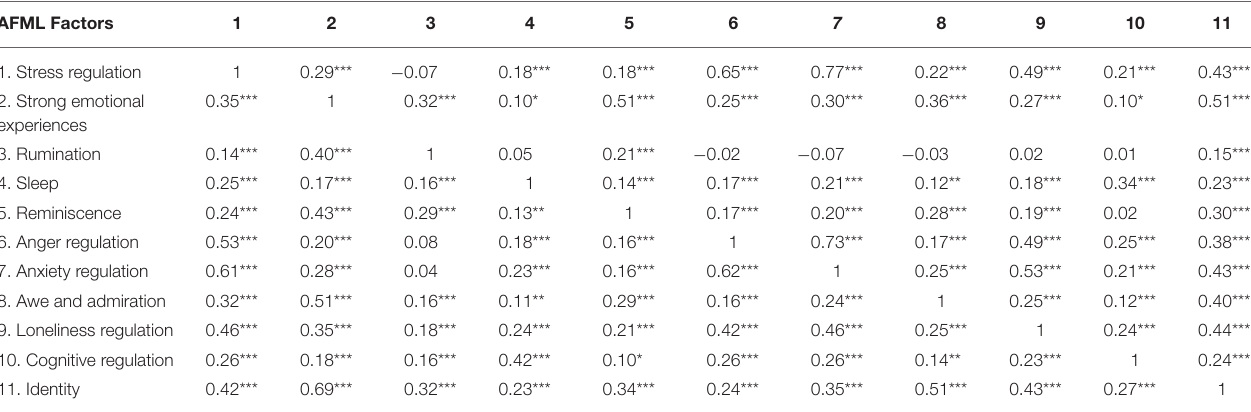
TABLE 5 | Bivariate correlations between factors of the AFML scale in the development sample (below the main diagonal), and bivariate correlations between factors of the AFML scale in the confirmatory sample (above the main diagonal). AFML